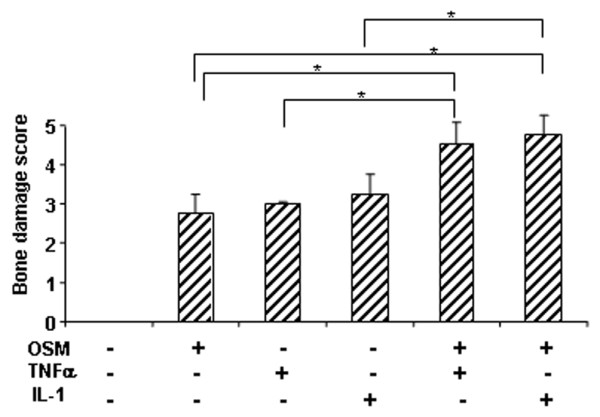
Quantitative analysis of bone damage. Mice (n = 4 for each treatment group) were injected with the adenoviral vectors expressing oncostatin M (OSM), IL-1 or tumour necrosis factor alpha (TNF-α) as described in Fig. 1. Sections (5 μm) were stained with H&E and were scored for bone damage as described in Materials and methods. The values represent the mean ± standard error of the mean for each treatment group (the control scored 0). The total scores are the combined scores of the four mice in each treatment group. Statistical differences between each treatment within experiments were determined using Student's t test: * P ≤ 0.05.